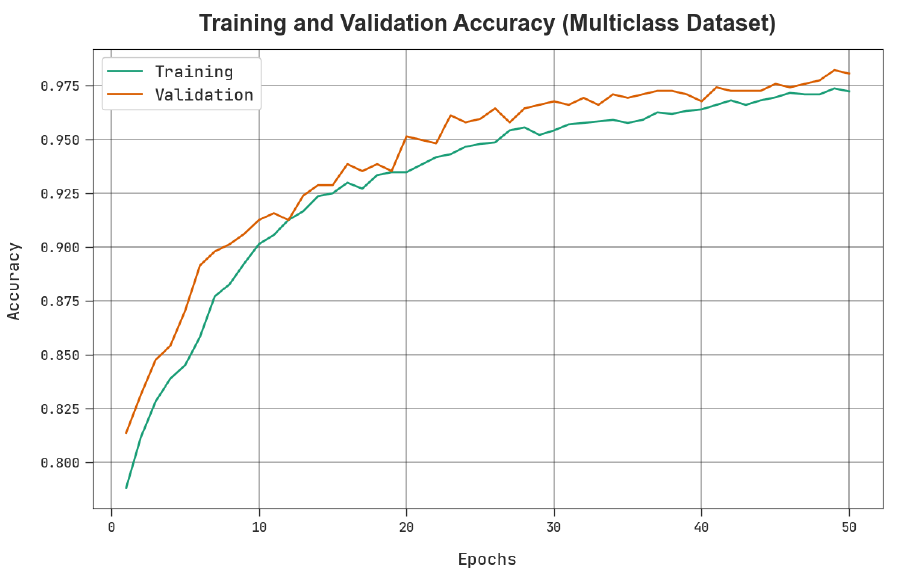
Figure 9. Accuracy curve of the H3SC-DLIDS approach on multiclass dataset.